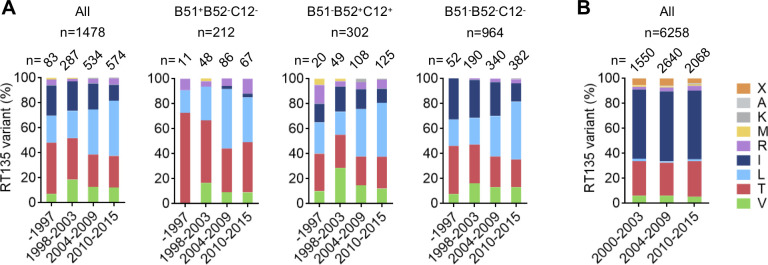
Amino acid variation at RT135 in Japanese and Canadian individuals with subtype B HIV-1 over 2 decades.A. HIV-1 RT135 amino acid frequencies in 1,478 Japanese non-hemophiliac individuals with chronic HIV-1 subtype B before 1997, and between 1998–2003, 2004–2009, and 2010–2015. The cohort is analyzed overall, and stratified by HLA allele carriage as follows: HLA-B*51:01+B*52:01-C*12:02- (n = 212); HLA-B*51:01-B*52:01+C*12:02+ (n = 302); and HLA-B*51:01-B*52:01-C*12:02- (n = 964). Statistical analysis was conducted using the Cochran-Mantel-Haenszel test (See also S2 Table). B. RT135 amino acid frequencies in 6,258 Canadian individuals with chronic HIV-1 subtype B recruited from 2000 to 2015. "X" indicates a mixture of two or more amino acids at that residue (as bulk HIV-1 sequencing was performed).